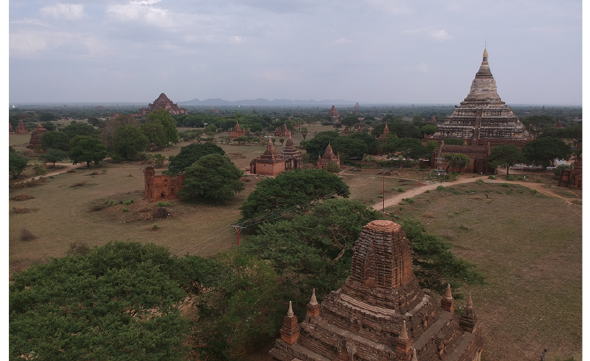
Figure 3. Aerial photography of Old Bagan (Myanmar).